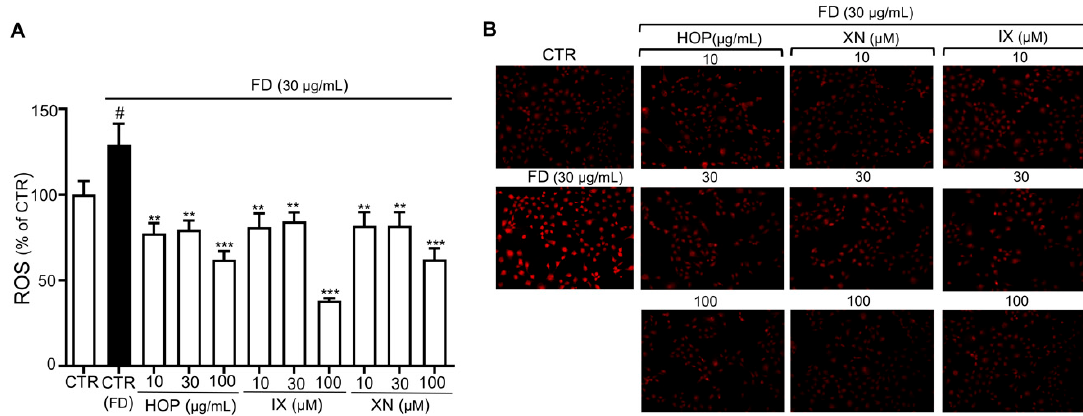
Figure 4. HOP and its major compounds XN / IX prevent FD-induced premature senescence by reducing oxidative stress in ECs. ( A ) Reactive oxygen species (ROS) levels were determined by measuring relative 2',7'-dichlorofluorescein-diacetate (DCF-DA) fluorescence intensity and were calculated as a percentage of the control (CTR). Data are expressed as the mean ± SEM ( n = 5); # p < 0.05 vs. control (CTR); ** p < 0.01, *** p < 0.001 vs. FD alone (CTR-FD). ( B ) Representative figure of fluorescence microscopy of redox-sensitive fluorescent dye (dihydroethidium, DHE) staining of live adherent passage 1 (P1) ECs in presence of FD alone or in combination with HOP (10, 30 μ g/mL) and XN/IX (10, 30 μ M respectively).